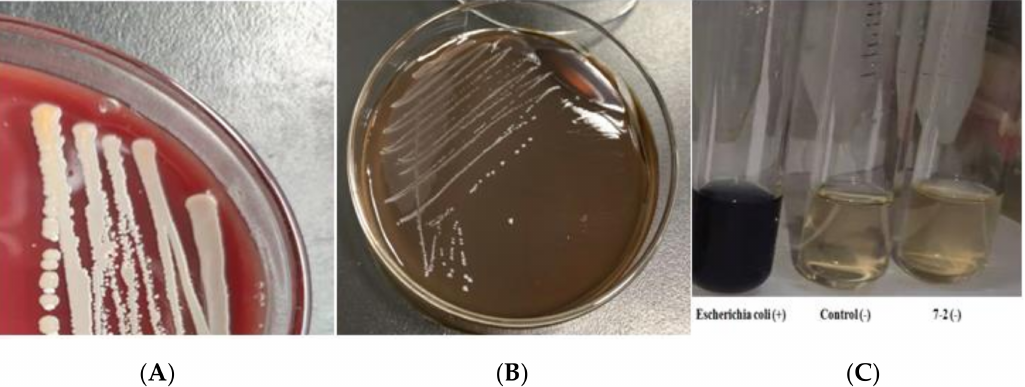
Figure 3. Hemolysis and nitrate reductase test. Picture ( A ) shows the hemolysis positive control and picture ( B ) shows the hemolysis of L. plantarum 7-2. Picture ( C ) shows nitrate reductase test.